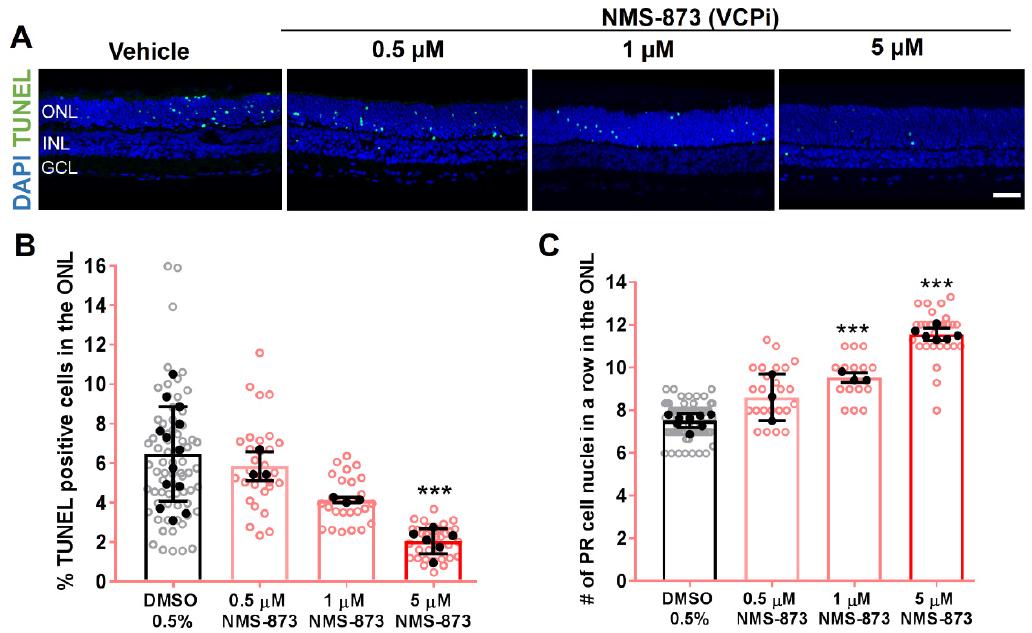
Figure 4. VCP inhibition significantly reduced the number of dying cells and increased cell survival in RHO P23H rats in vitro. Retinae from RHO P23H transgenic rats were explanted at postnatal day 9, cultivated for 6 days (PN9 DIV6), and treated every second day with different concentrations of the VCP inhibitor NMS-873. 0.5% DMSO was applied as corresponding vehicle control. ( A ) TUNEL assay reveals photoreceptors undergoing cell death (green); nuclei were counterstained with DAPI (blue). ( B ) Bar chart shows the percentage of TUNEL-positive cells in the ONL. A decrease in the percentage of dying cells was observed after NMS-873 treatment in a dose-dependent manner, significant at 5 µM. ( C ) Comparison of the number of remaining photoreceptor cell nuclei in a row in the ONL. Retinae treated with VCP inhibitor NMS-873 showed higher numbers of photoreceptor cell rows. Scale bar is 50 µm. Values were quantified by scoring several images (open circles) from P23H retinae (closed circles; n = 13 for TUNEL assay, n = 9 for cell rows) per treatment for DMSO 0.5%, 3 retinae (n = 3) for 0.5 and 1 µM NMS-873 and 6 retinae (n = 6) for 5 µM NMS-873. The data are presented as mean ± SD, and one-way ANOVA analysis was performed. *** p < 0.001. VCPi: VCP inhibitor; ONL: outer nuclear layer; INL: inner nuclear layer; GCL: ganglion cell layer; DIV: days in vitro; PR: photoreceptor.